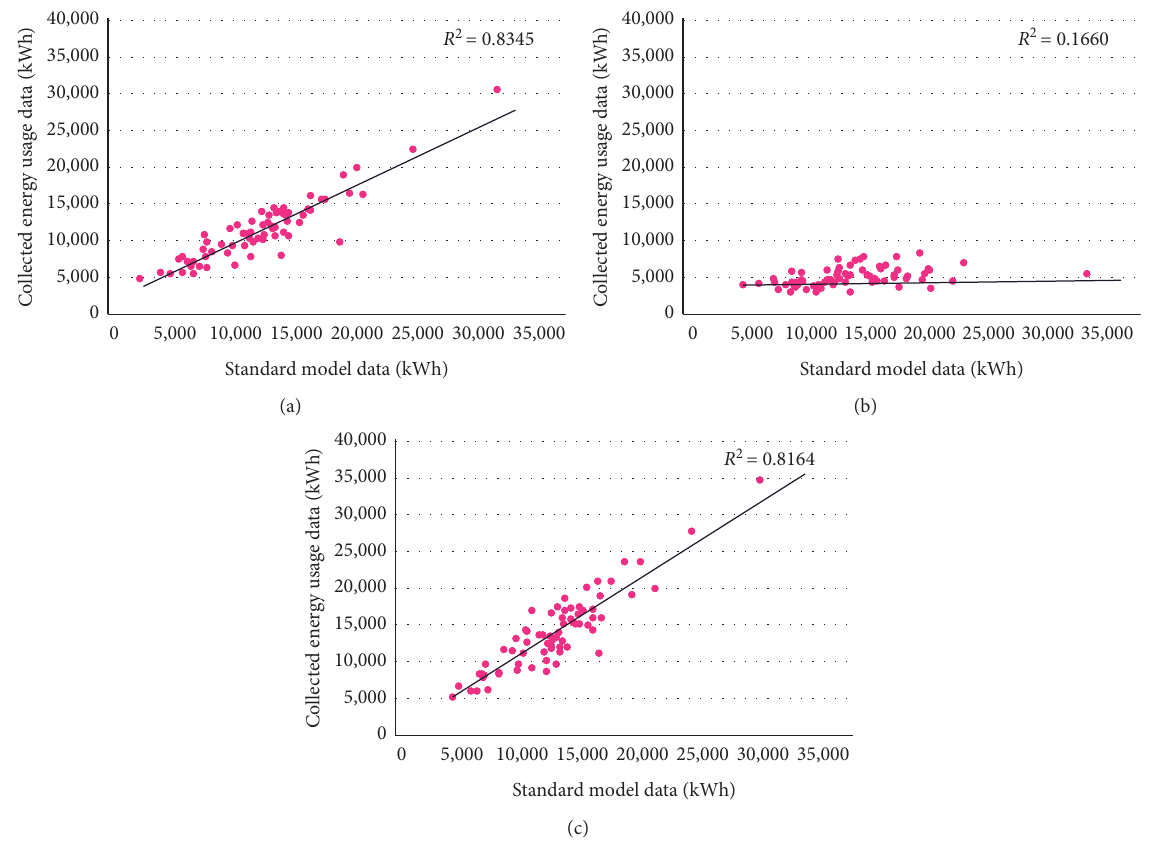
Figure 13: Analysis of standard model and collected energy usage data. (a) Analysis of gas energy consumption correlation. (b) Analysis of electric energy consumption correlation. (c) Analysis of total energy consumption